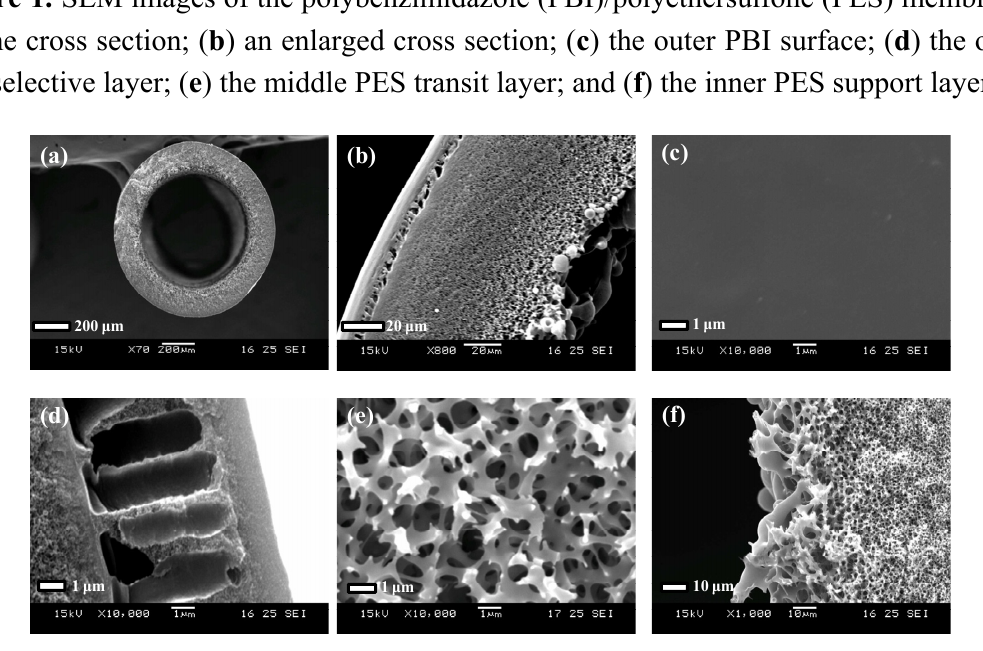
Figure 2. SEM images of the annealed PBI-polyhedral oligomeric silsesquioxane (POSS)/polyacrylonitrile (PAN) membrane: ( a ) the cross section; ( b ) an enlarged cross section; ( c ) the outer PBI surface; ( d ) the outer PBI selective layer; ( e ) the middle PAN transit layer; and ( f ) the inner PAN support